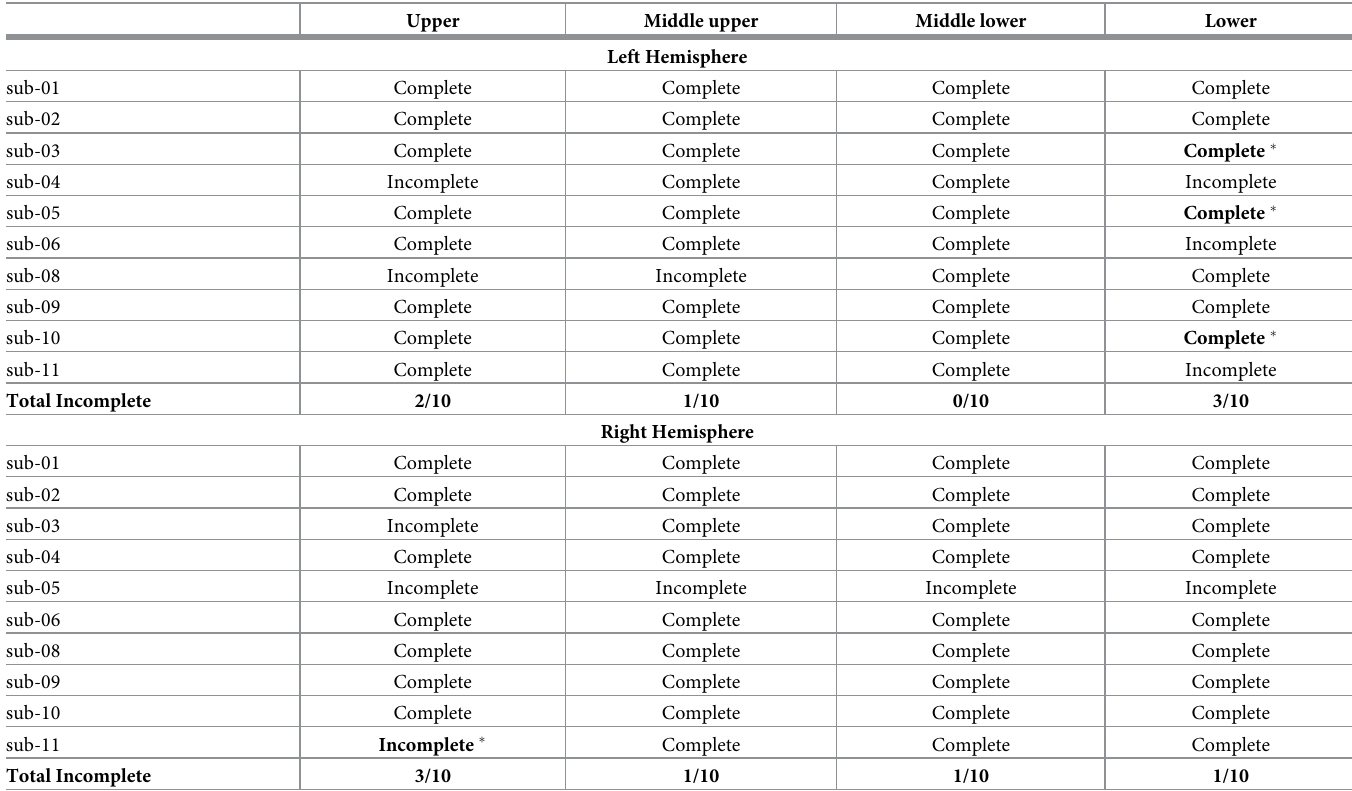
Table 2. hV4 visual field coverage after correcting inverted